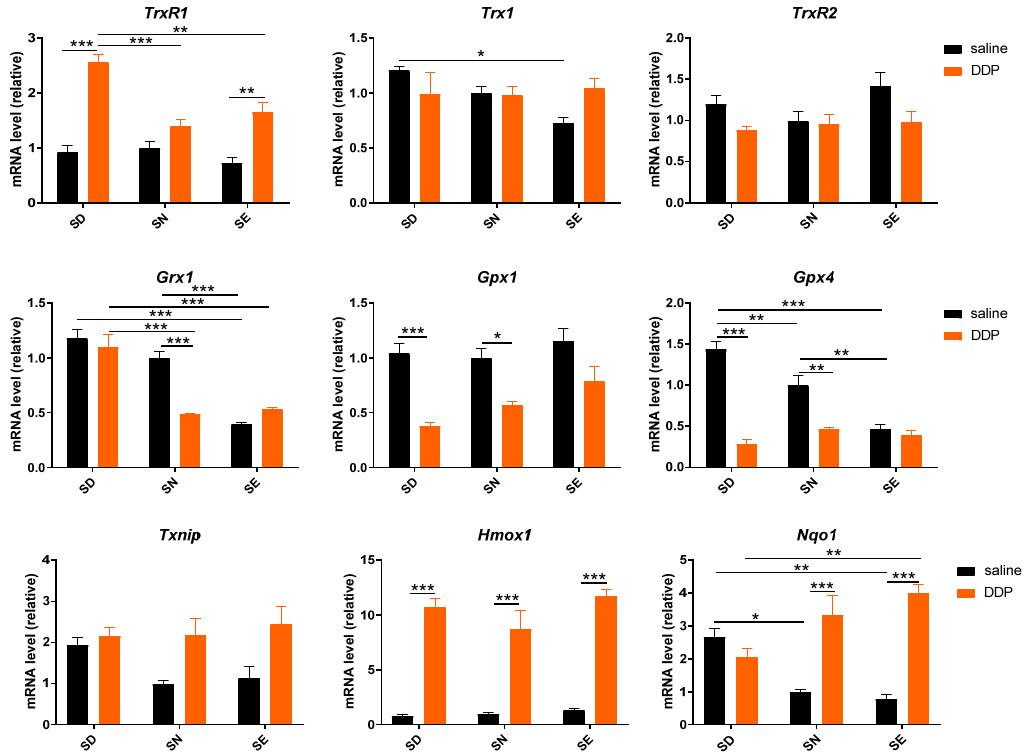
Figure 5. mRNA level of antioxidant enzymes in mouse kidney following the treatment with DDP. mRNA level of GAPDH was used as the control, related mRNA levels were shown as 2 − ( ∆∆ Ct) . Data are normalized using the value from samples of SN saline group as control (=1) and presented as mean ± SEM; * p < 0.05; ** p < 0.01; *** p < 0.001; two-way ANOVA, n = 4. SD, selenium-deficient; SN, selenium-normal; SE, selenium-enriched; DDP,